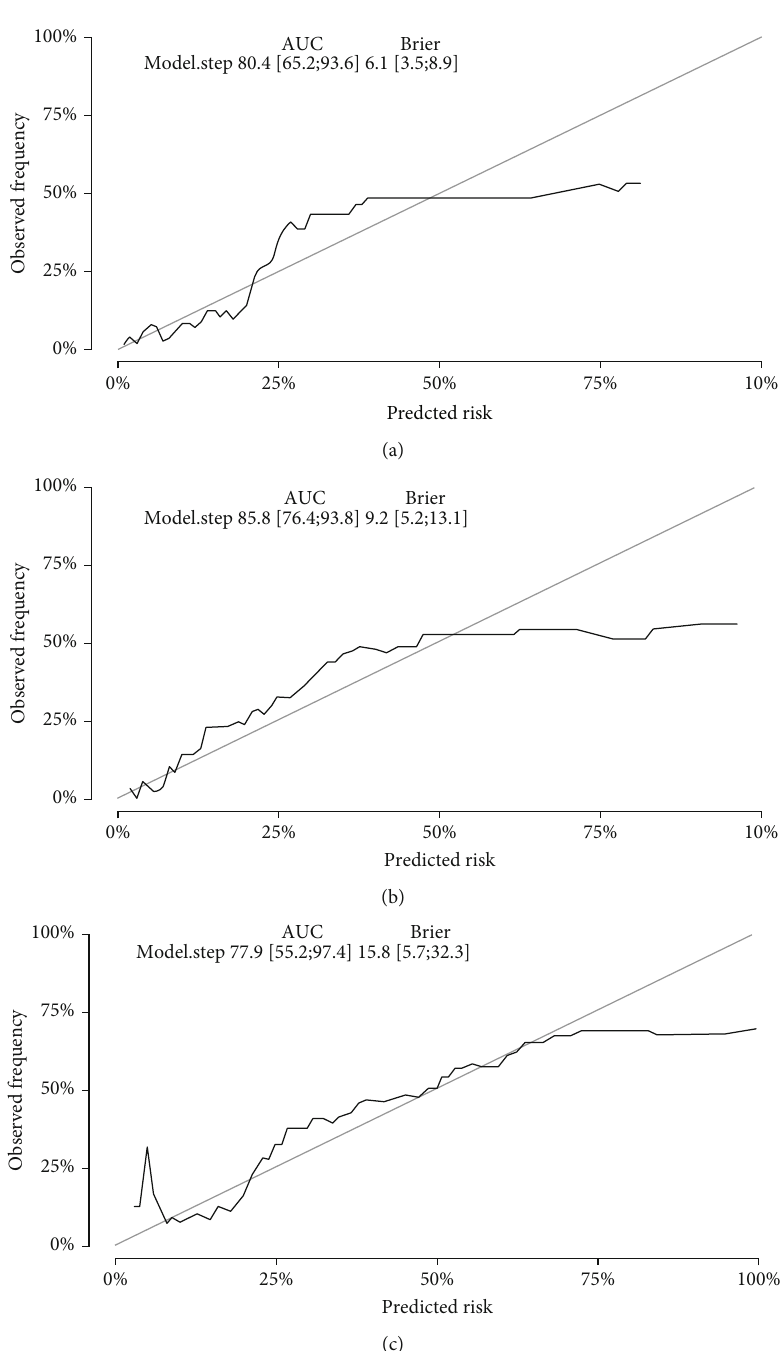
Figure 4: c -indices and calibration curves for the new model. 200 sample bootstrapped calibration plots for the prediction of 1 – 3-year renal survival are shown. The gray line represents the ideal fi t while the black line represents practical fi t. The c -indices for 1-3 years were 0.80 (95% CI: 0.65-0.94), 0.86 (95% CI: 0.77-0.94). and 0.78 (95% CI: 0.55-0.97), respectively. Brier scores were 0.06 (95% CI: 0.04-0.09), 0.09 (95% CI: 0.05-0.13). and 0.16 (95% CI: 0.06-0.32),